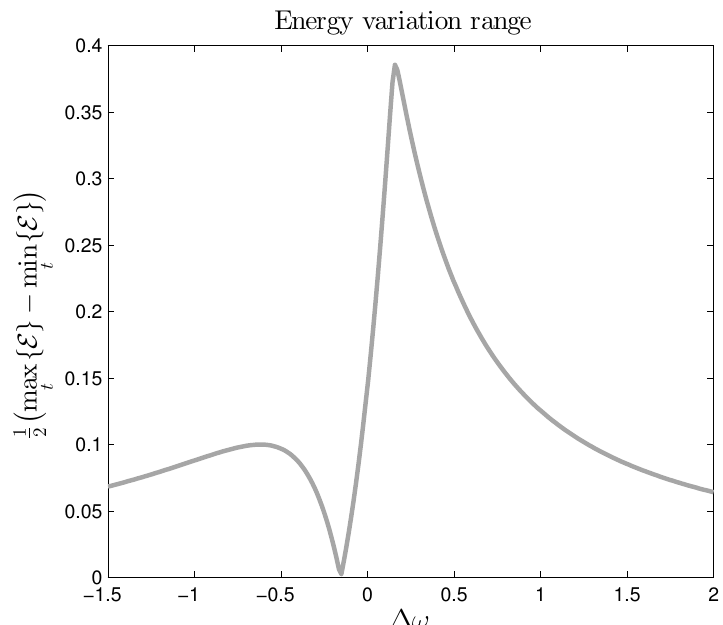
Figure 3. Typical dependence of the energy variation range ∆ E on the frequency detuning ∆ ω for the case when the high frequency mode ω 3 has the lowest energy (initial condition from Table 1).